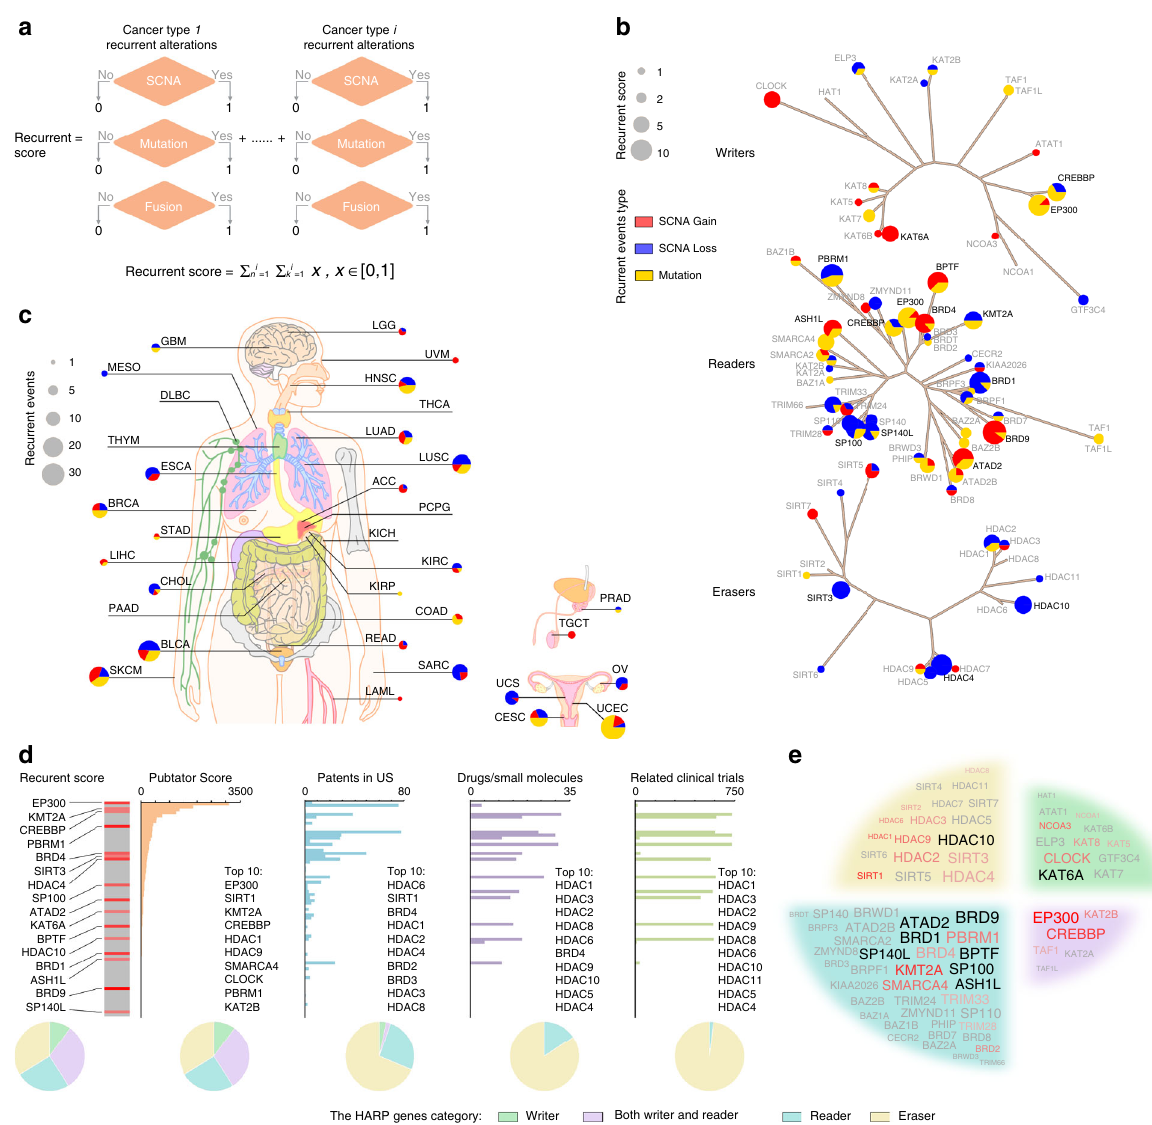
Fig. 7 Putative therapeutic target HAMPs across cancers. a The work fl ow for the putative therapeutic target HAMP analysis. An unweighted numeric sum of the numbers of recurrent events for a given HAMP was calculated across all cancer types (referred to as the pan-cancer recurrent score). b Summary of the recurrent score of the putative cancer-causing HAMPs driven by recurrent genomic alterations. The size of the bubble: the overall recurrent score. Red: ampli fi cation; blue: deletion; yellow: mutation. The HAMPs coding in black and gray indicate a gene with overall recurrent score ≥ 6 and < 6, respectively. The phylogenetic trees were generated by multiple sequence alignments of the full-length sequences of the proteins. c Summary of the recurrent events of the HAMPs in each cancer type. The size of the bubble: total recurrent events. Red: ampli fi cation; blue: deletion; yellow: mutation. The phylogenetic trees were generated by multiple sequence alignments of the full-length sequences of the proteins. d Summary of the results of a database search for publications, patent applications, small molecule drugs, and clinical trials related to each HAMP. The HAMPs are ranked according to their PubTator scores. HAMPs with overall recurrent scores > 5 are highlighted as red bars. The color intensity represents the recurrent score. The pie diagrams at the bottom summarize the percentages of the HAMPs that are writer, both writer and reader, reader, and eraser genes for potential targets, publications, patent applications, small molecular drugs, and clinical trials. e A word cloud of the putative therapeutic target HAMPs identi fi ed in this study. The size of the font represents the recurrent score. The color of the font indicates the type of genomic alterations. Black: understudied targets (PubTator score < 150 and recurrent score > 5); red: well-studied targets (PubTator score ≥ 150 and recurrent score > 5; the intensity of red indicates the PubTator score);